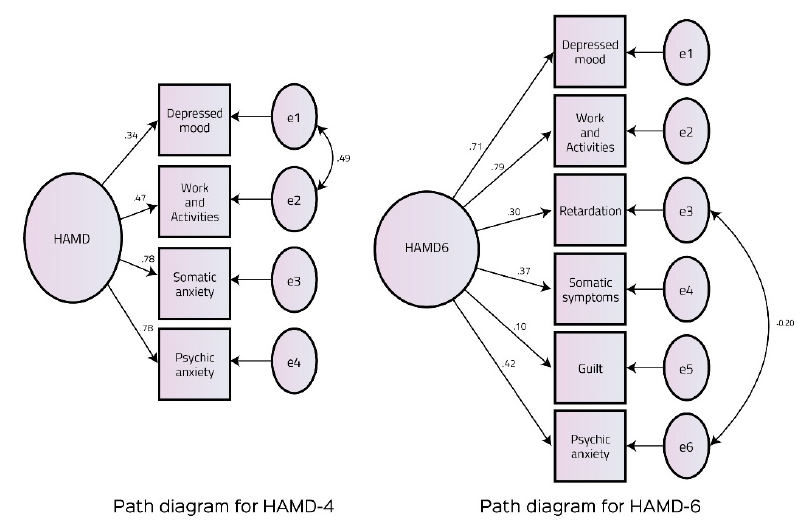
Figure 4. Path diagrams for the HAMD-4 and HAMD-6.